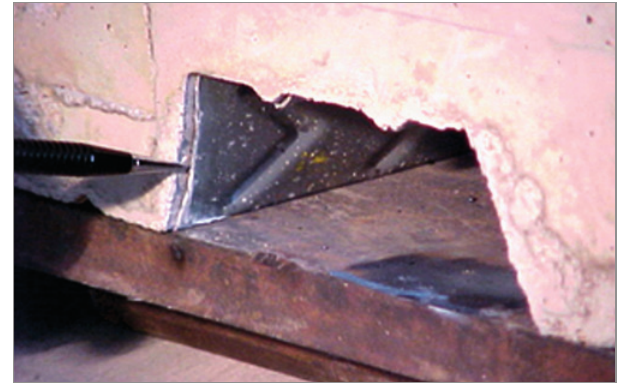
Figure 5 Load versus midspan deflection of the specimen 01A